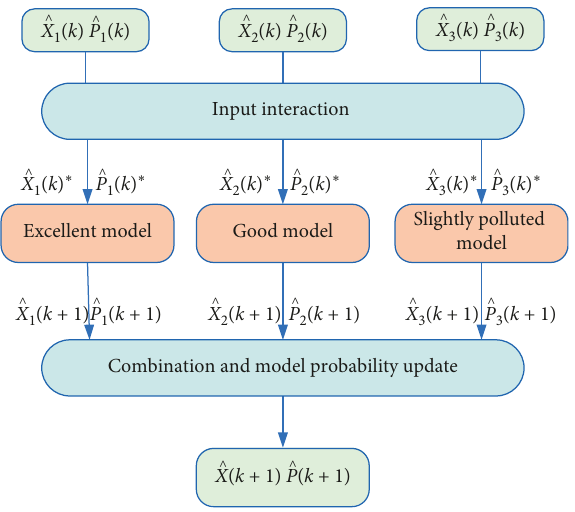
Figure 4: Flow chart of